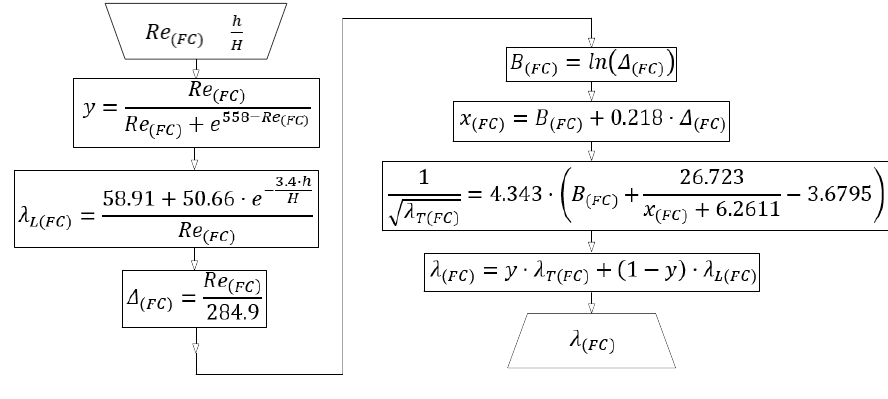
Figure 2. Algorithm for solving Equation (12).